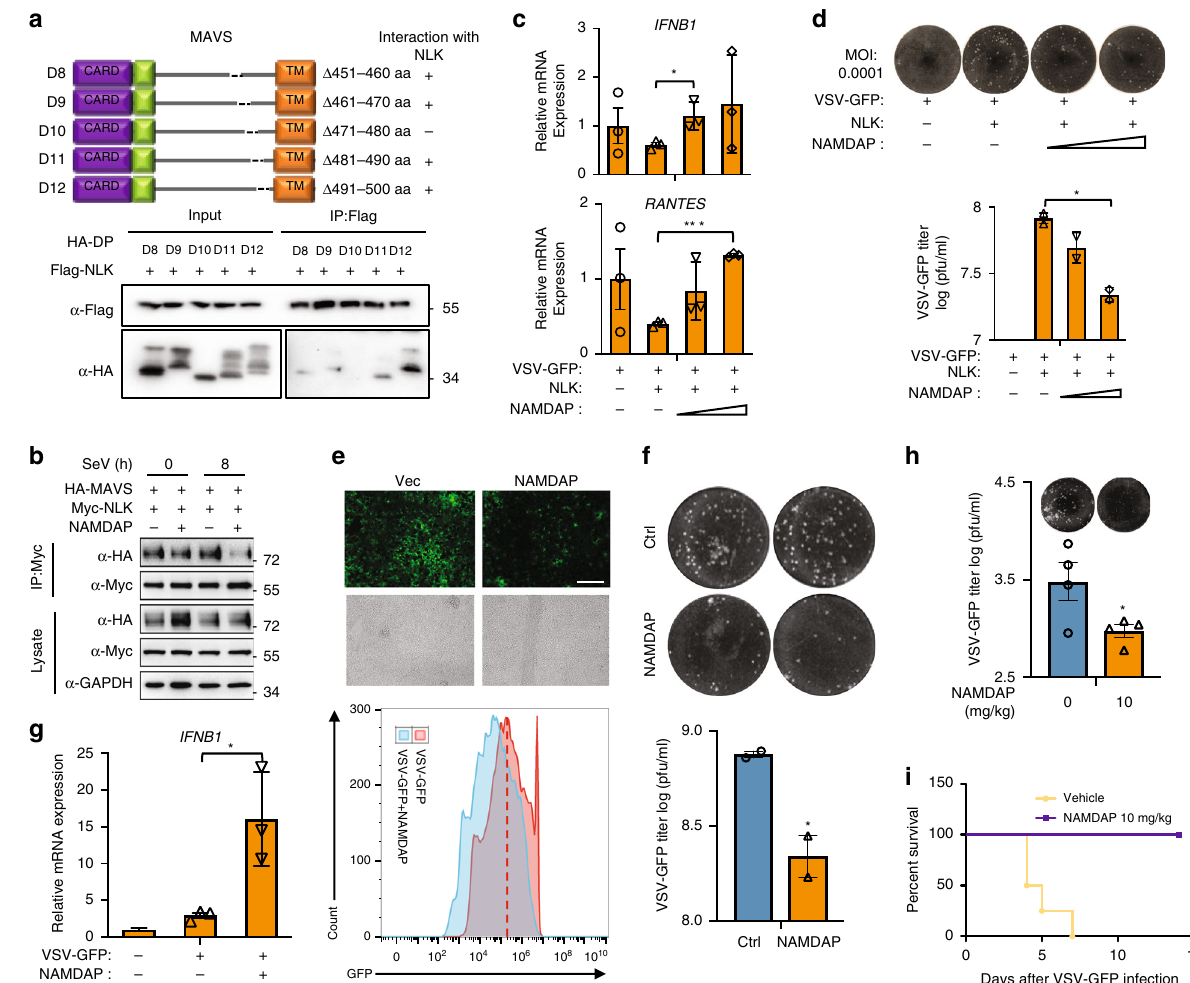
Fig. 8 A peptide from MAVS potentiates the antiviral response in vitro and in vivo. a Characterization of the interaction domain between NLK and MAVS. HEK293T cells were transfected with the MAVS mutants and NLK, immunoprecipitated using the Flag antibody, and then subjected to immunoblot analysis. b Effect of NAMDAP on the interaction between NLK and MAVS. HEK293T cells were transfected with NLK and MAVS, MG132 was added to protect MAVS from degradation, and 20 µ g/ml NAMDAP and SeV were added for 8 h before performing immunoprecipitation experiments. Immunoblot analysis was performed using the indicated antibody. c , d Effect of NAMDAP on the inhibitory effect of NLK on MAVS toward IFNB1 and RANTES gene transcription and the antiviral response. c HEK293T cells expressing NLK were incubated with increasing amounts of NAMDAP before performing real- time PCR experiments ( n = 3). d HEK293T cells expressing NLK were incubated with VSV-GFP at an MOI of 0.0001 and increasing amounts of NAMDAP, followed by plaque assays ( n = 2). e – g Effect of NAMDAP on the production of antiviral cytokines and the antiviral response in vitro. HEK293T cells were infected with VSV-GFP at an MOI of 0.01 followed by monitoring via FACS analysis ( e ). Scale bar is 500 µ m. The supernatant was collected and added to Vero cells before performing the plaque assay ( f ) ( n = 2). mRNA was isolated to determine the transcription level of IFNB1 ( g ) ( n = 3). h , i Effect of NAMDAP on the antiviral response in vivo. Mice (12) were infected with VSV-GFP (2 × 10 8 pfu), after which 10 mg/kg NAMDAP or vehicle was injected three times every 4 h via the tail vein. Their sera were collected after 12 h and subjected to the plaque assay ( g ). Survival assay of mice (four for each) injected with or without NAMDAP. The survival of the mice was monitored for 2 weeks ( h ) ( n = 4). NAMDAP: NLK-associated and MAVS-derived antiviral peptide. Data are representative of three independent experiments. Data are presented as the mean ± SEM. Statistical signi fi cance was analyzed by ANOVA or Student ’ s t -test (* p < 0.05, *** p < 0.001). Source data ( a – d , f – h ) are provided as a Source Data fi